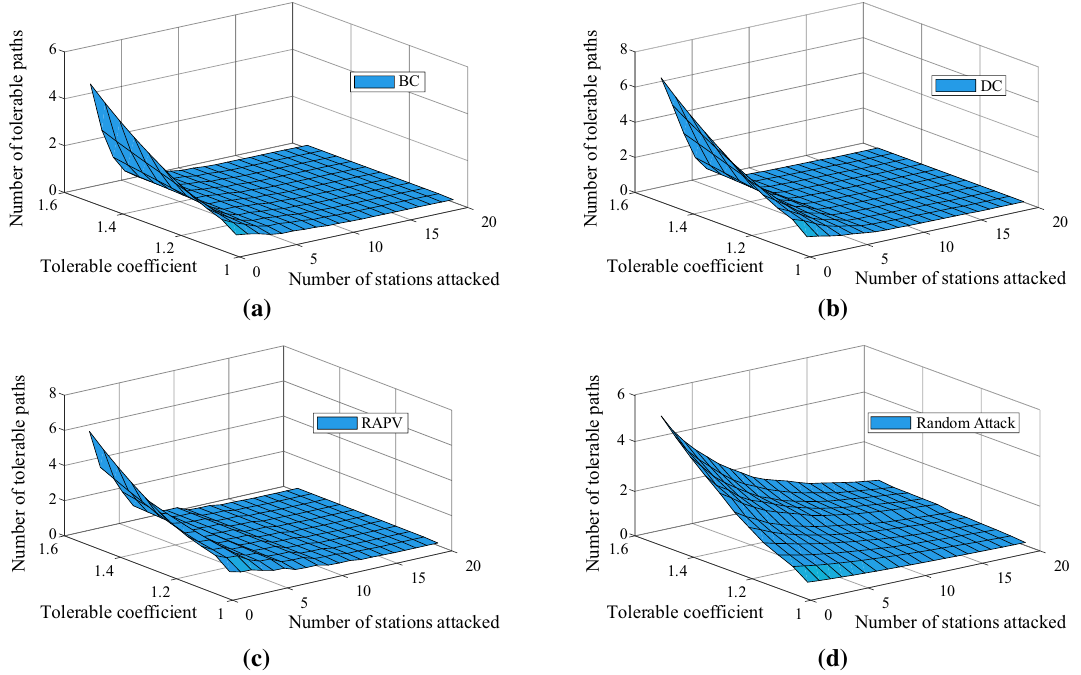
Fig. 5 Sensitivity of passenger tolerability coefficient to the average number of tolerable travel paths on Wuhan’s subway network during peak hours